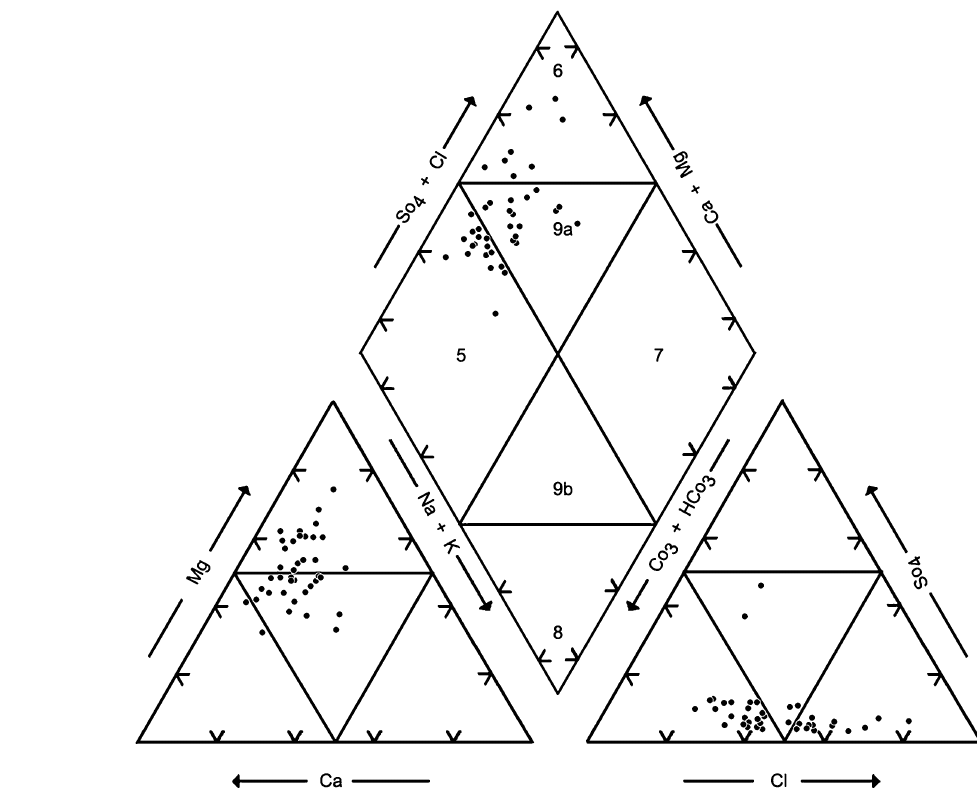
Fig. 2 Trilinear diagram for